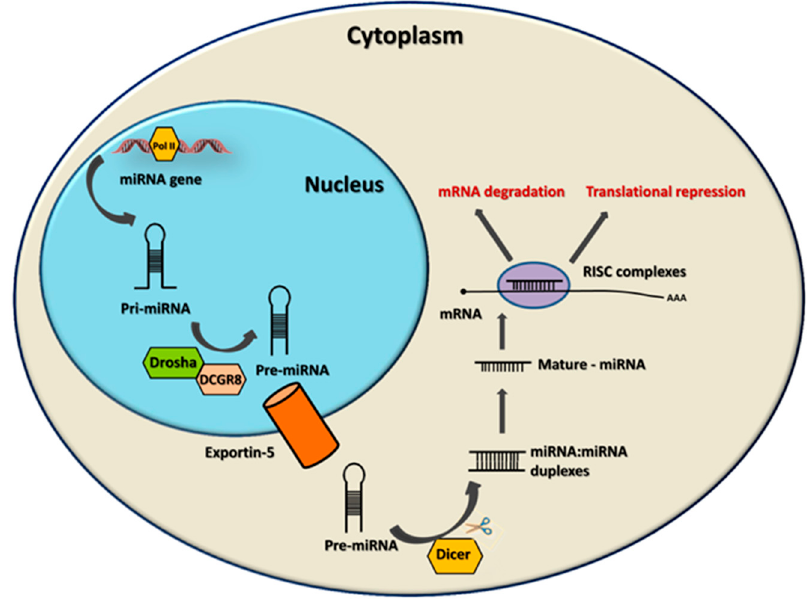
Figure 1. Biogenesis of microRNA (miRNA). miRNAs genes are transcribed as primary miRNAs (pri-miRNAs) by RNA polymerase II (Pol II) in the nucleus. The pri-miRNAs are cleaved by the Drosha–DGCR8 complex to produce a precursor miRNA (pre-miRMA), which is then exported to the cytoplasm by the exportin-5-RNA GTP complex. In the cytoplasm, the pre-miRMA is further processed by Dicer to a short RNA duplex. One strand is degraded, while the mature miRNA is incorporated into the RNA-induced silencing complex (RISC), which leads to targeting an mRNA, leading to its degradation or the repression of translation.